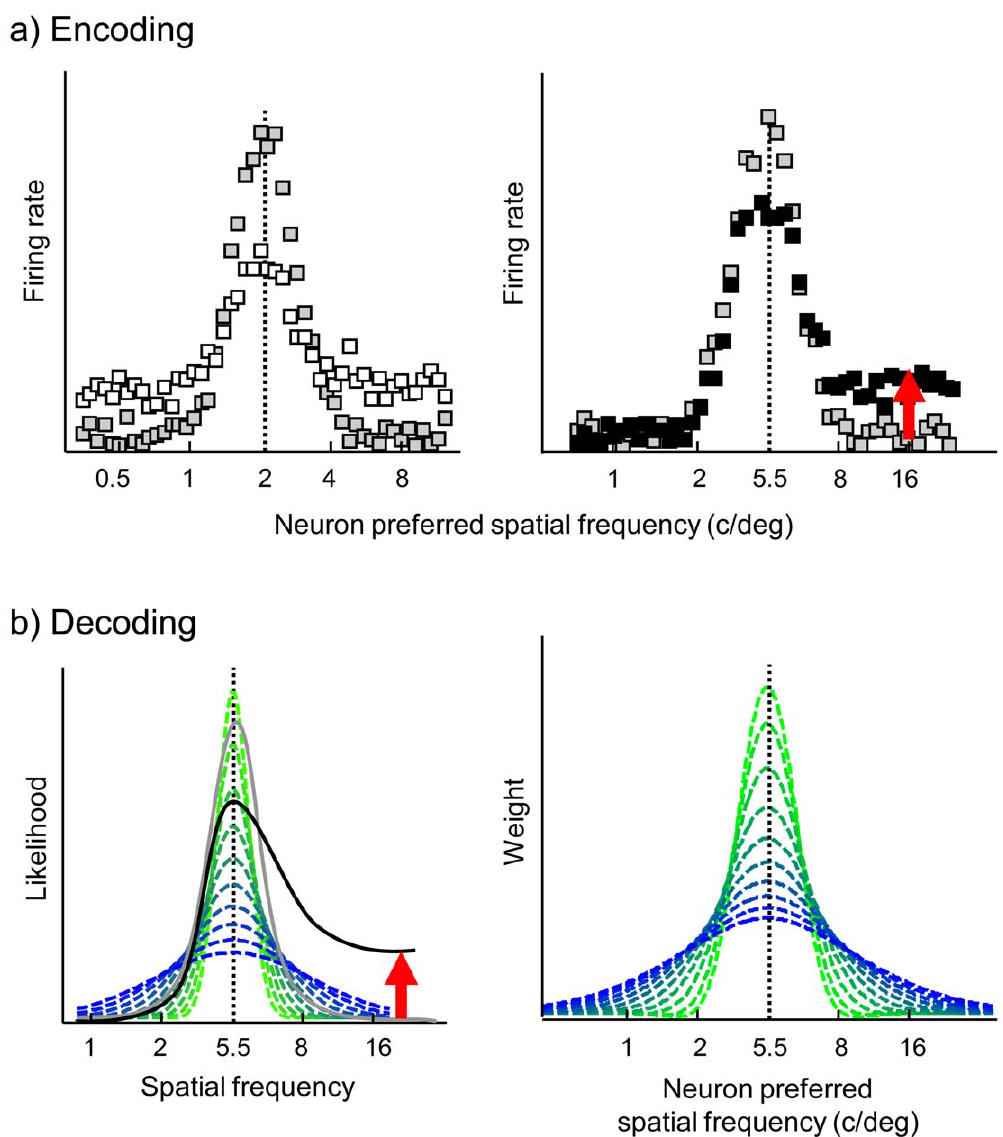
Figure 4. Overview of the population code model. (a) Model of V1 encoding of gratings in filtered noise. Left panel: simulated V1 responses to a grating of 2 c/deg in the absence of external noise (gray symbols) and in the presence of white noise (white symbols). Right panel: simulated V1 responses to a grating of 5.5 c/deg in the absence of noise (gray symbols) and in the presence of high-pass filtered noise (black symbols). It can be seen that visual noise reduces the response of informative neurons tuned to the grating frequencies while increasing the activity of neurons tuned to the noise pass-band. Consequently, the population response is asymmetrical in filtered noise. (b) Decoding of grating spatial frequency. Left panel: Reduced log likelihood function for the population response to a 5.5 c/deg grating in the absence of external noise (gray line) and in the presence of high-pass filtered noise (black line). Embedding the grating in high-pass noise increases the log likelihood of high spatial frequencies relative to the veridical frequency of 5.5 c/deg. The reduced log likelihood function is thus asymmetrical in filtered noise. The broken lines represent the read-out functions assumed when sampling discrete likelihood values. Right panel: the linear weighting profiles corresponding to the read-out functions. The likelihood of a specific grating spatial frequency can be obtained with high precision (left panel, green) by preferentially weighting the responses of neurons that are tuned to that specific frequency (right panel, green). Computing the likelihood of a grating spatial frequency with low precision (left panel, blue) corresponds to summing the responses of a broad population of neurons tuned to various spatial frequencies (right panel,